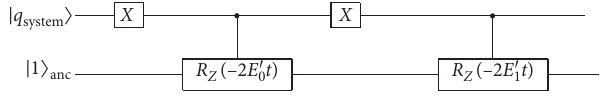
Figure 2: Implementation of the system’s evolution operator. | q 〉 is the state vector of the system’s qubit in the energy system